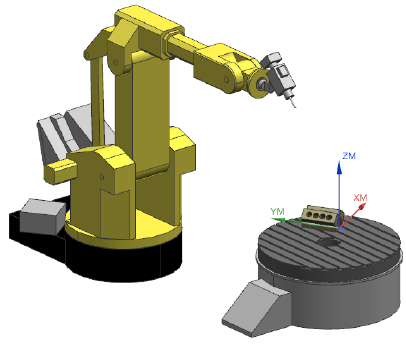
Figure 8. Optimized robotic deburring cell setup.